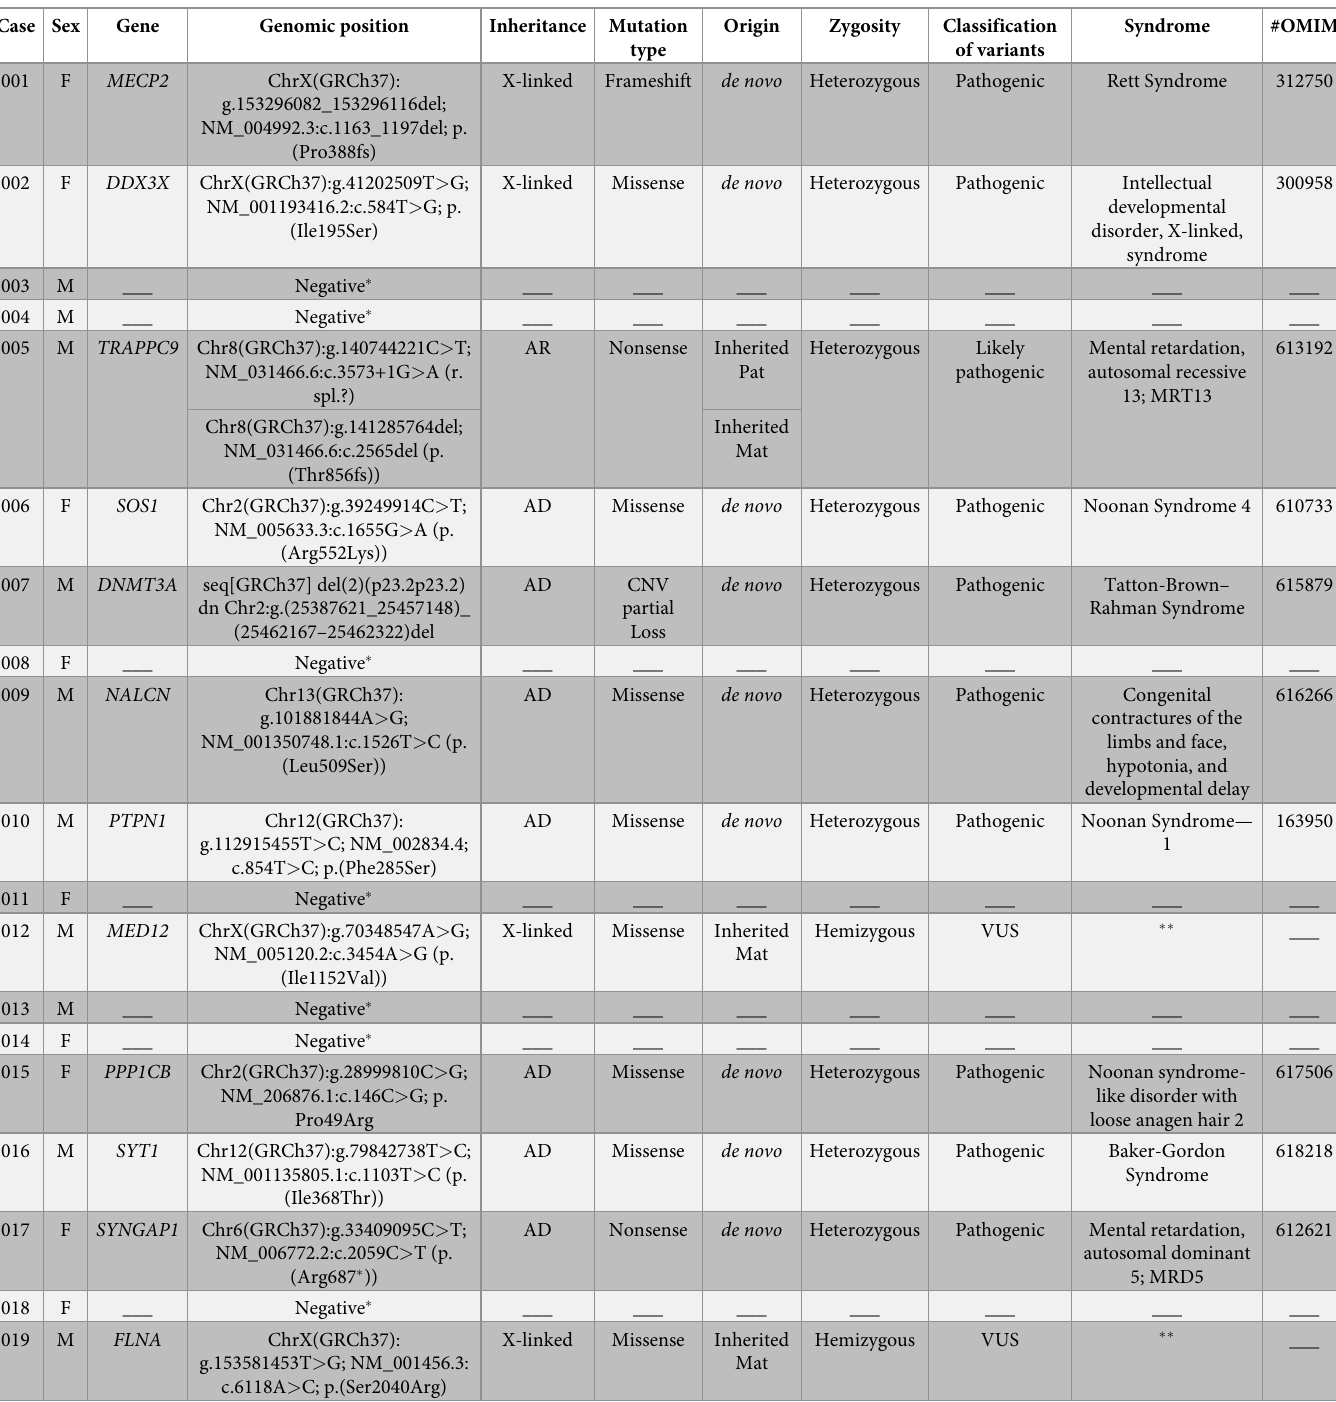
Table 1. Summary of the molecular results of cases with ID/GDD/MCA investigated with a target gene panel exome